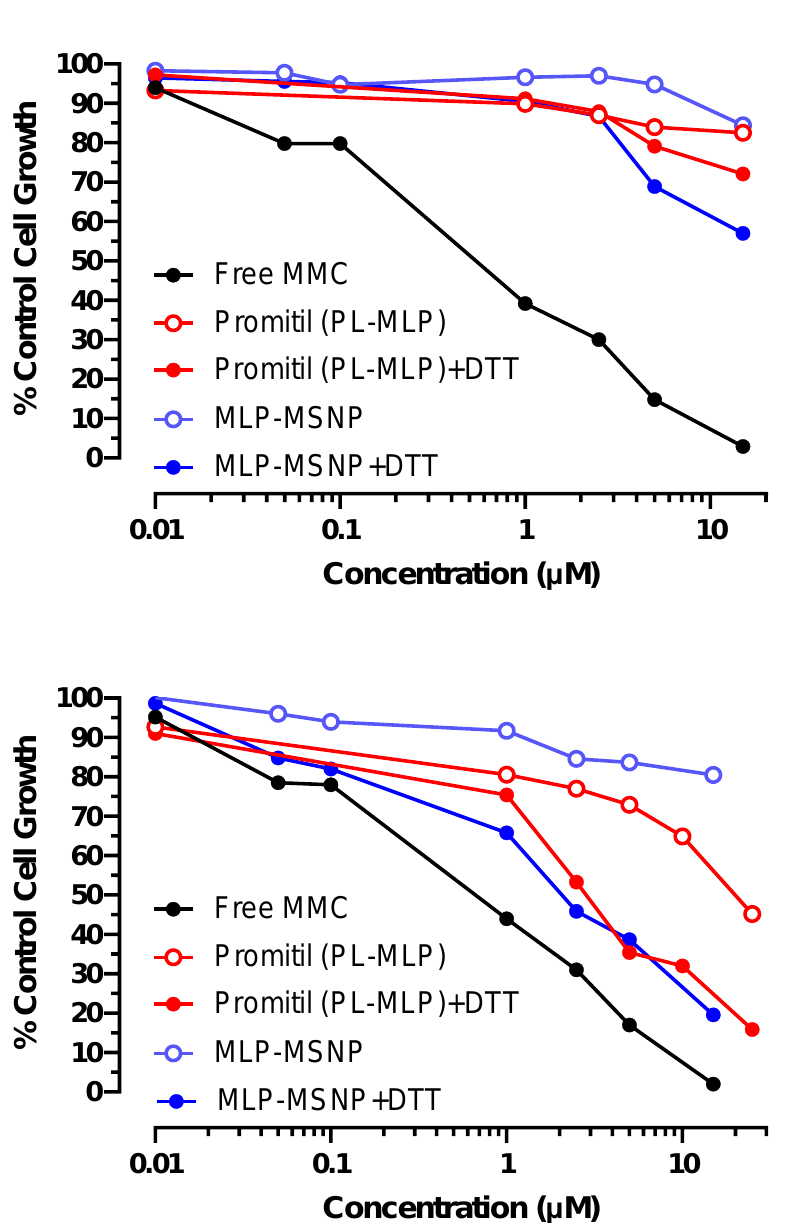
Figure 8. Cytotoxicity evaluation of KB cancer cells exposed to different concentrations of free MMC, Promitil (MLP-loaded liposomes) dispersed in medium ± DTT (0.5 mM), and MLP-loaded MSNPs dispersed in medium ± DTT (0.5 mM) (two independent experiments).